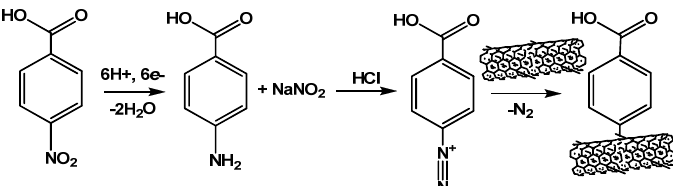
Figure 7. Principal scheme of modification of CNTs with carboxyphenyl radicals generated in situ from appropriate aromatic amine.